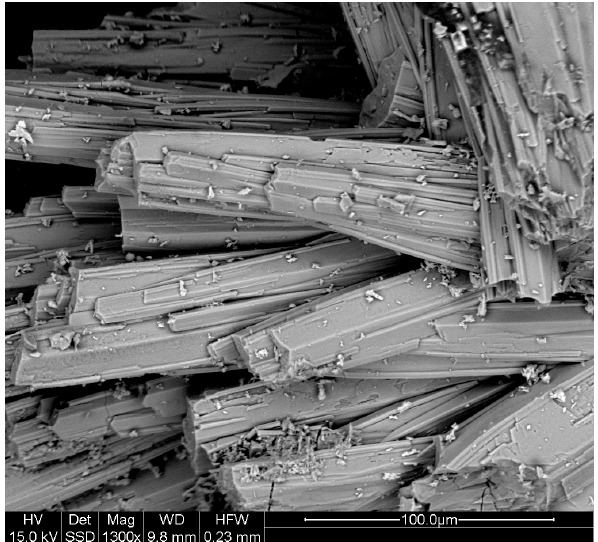
Figure 3. BSE image ( × 1300) of whiteite-(CaMnFe) crystals.